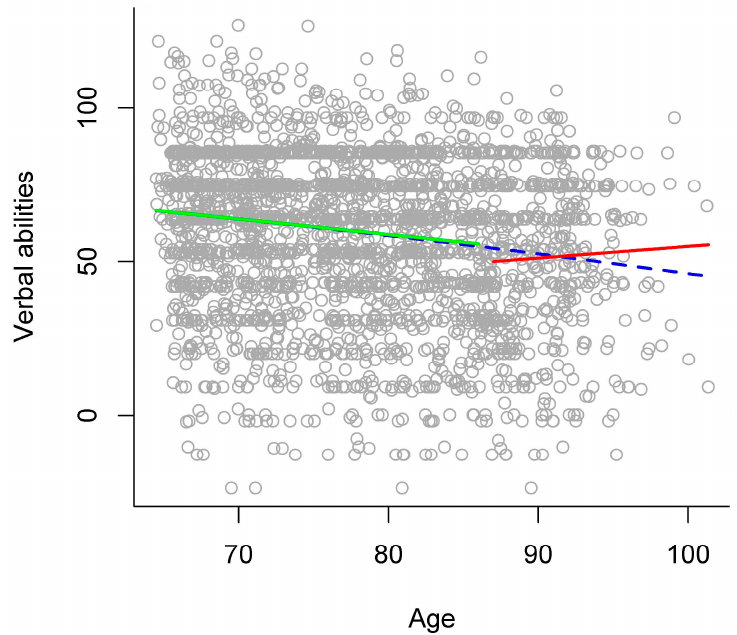
Figure 2. Age relations in verbal abilities. Scores in verbal abilities plotted against chronological age, with different models of age relations: gradual model (blue dashed line) and stage model (young-old adults: green solid line, versus old-old adults: red solid line).